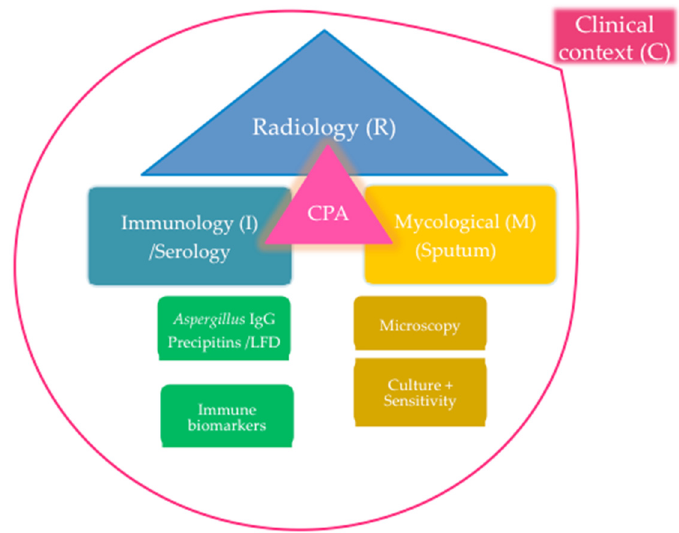
Figure 2. The Clinical, Radiological, Immunological and Mycological (CRIM) approach to the diagnosis of chronic pulmonary aspergillosis. LFD, lateral flow device; CPA, chronic pulmonary aspergillosis; PCR, polymerase chain reaction. The red circle emphasizes the fact that clinical, radiological and microbiological findings should be interpreted with respect to the patient’s clinical presentation.